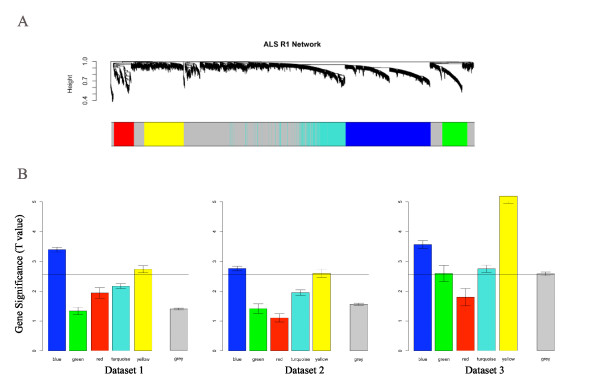
Gene co-expression modules in human whole blood. Detection of gene co-expression modules in human whole blood datasets comprised of ALS patients and matched controls. (a) Branches of the cluster dendrogram of the most connected genes gave rise to five gene coexpression modules (Blue, Green, Red, Turquoise and Yellow). Genes that could not be clustered into one of these modules were assigned to the Grey module. Every gene represents a line in the hierarchical cluster. Distance between two genes is shown as height on the y-axis. (b) Boxplots showing gene significance per module. Module significance was calculated by taking the average of the absolute t statistics of all genes within a module. The Blue and Yellow module were the only modules that were significant at a Bonferroni corrected significance threshold of 0.05/5 in all 3 datasets.